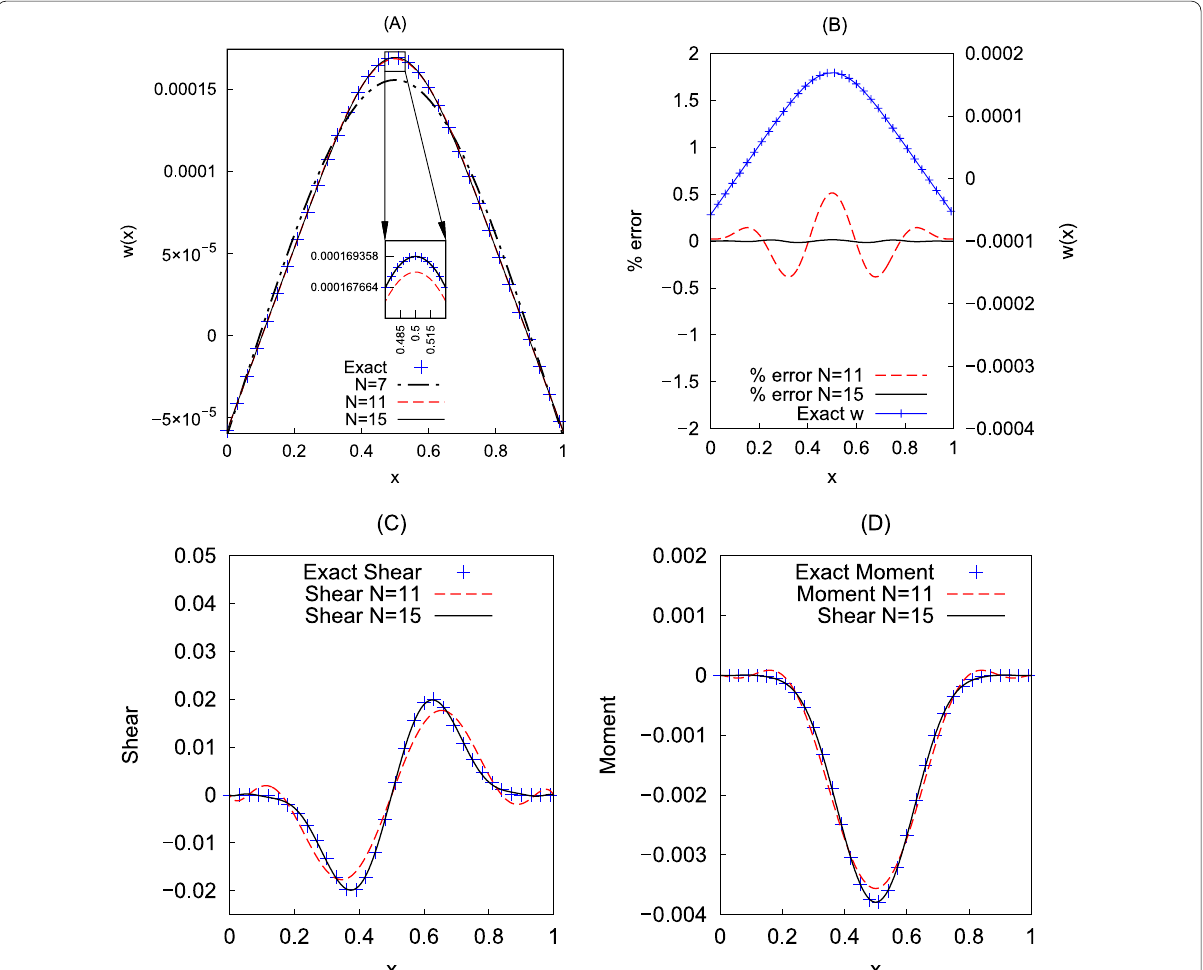
Fig. 12 Case (4) RRM and exact results. A Exact solution and RRM deflection. B Exact deflection and percentage error for various orders. C Exact and RRM shear. D Exact and RRM moment